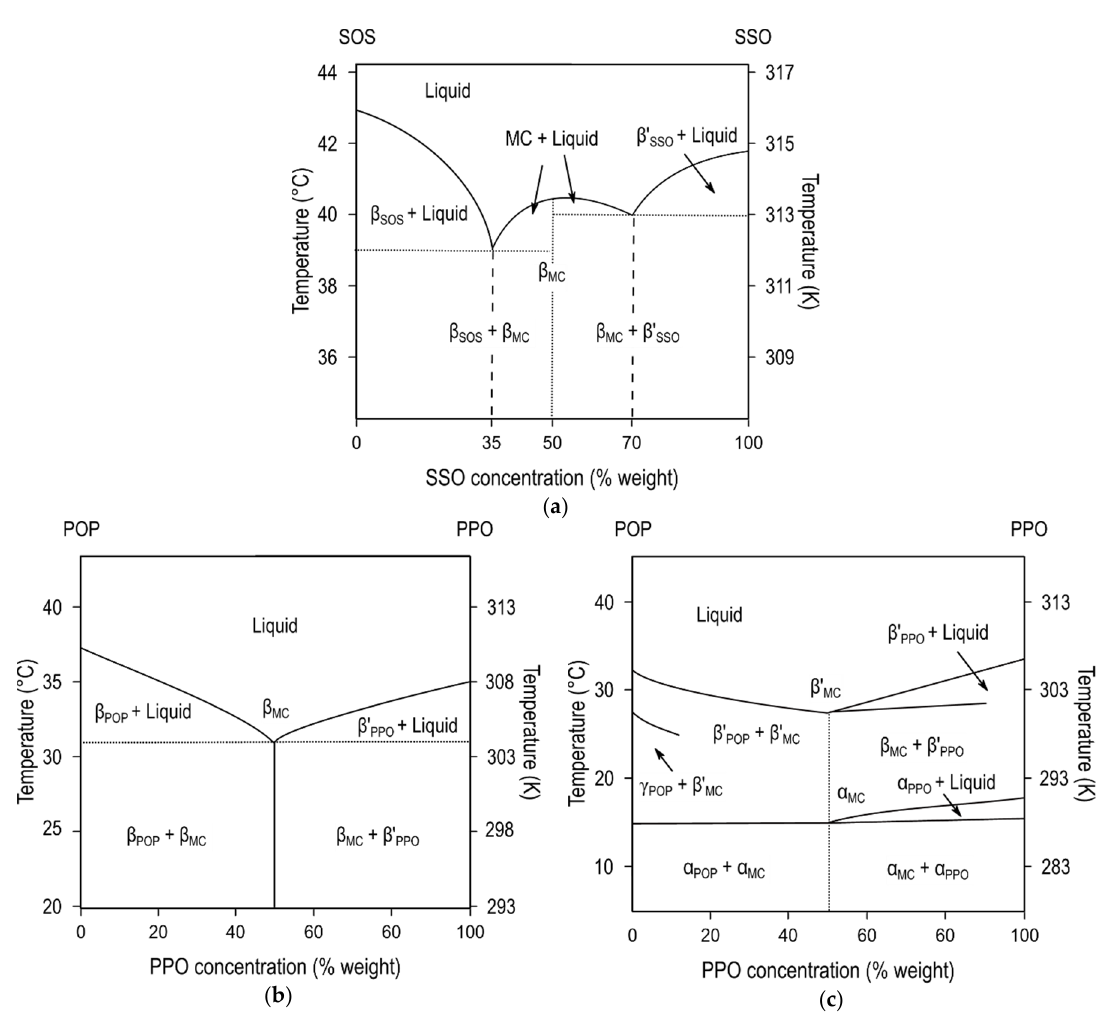
Figure 6. Phase diagrams of molecular compound-forming systems. ( a ) Stable diagram of SOS/SSO mixtures. Reprinted with permission from [115], © 2002 Elsevier. ( b ) Stable and ( c ) kinetic phase diagrams of POP/PPO system. Reprinted with permission from [57], © 1997 American Chemical Society.